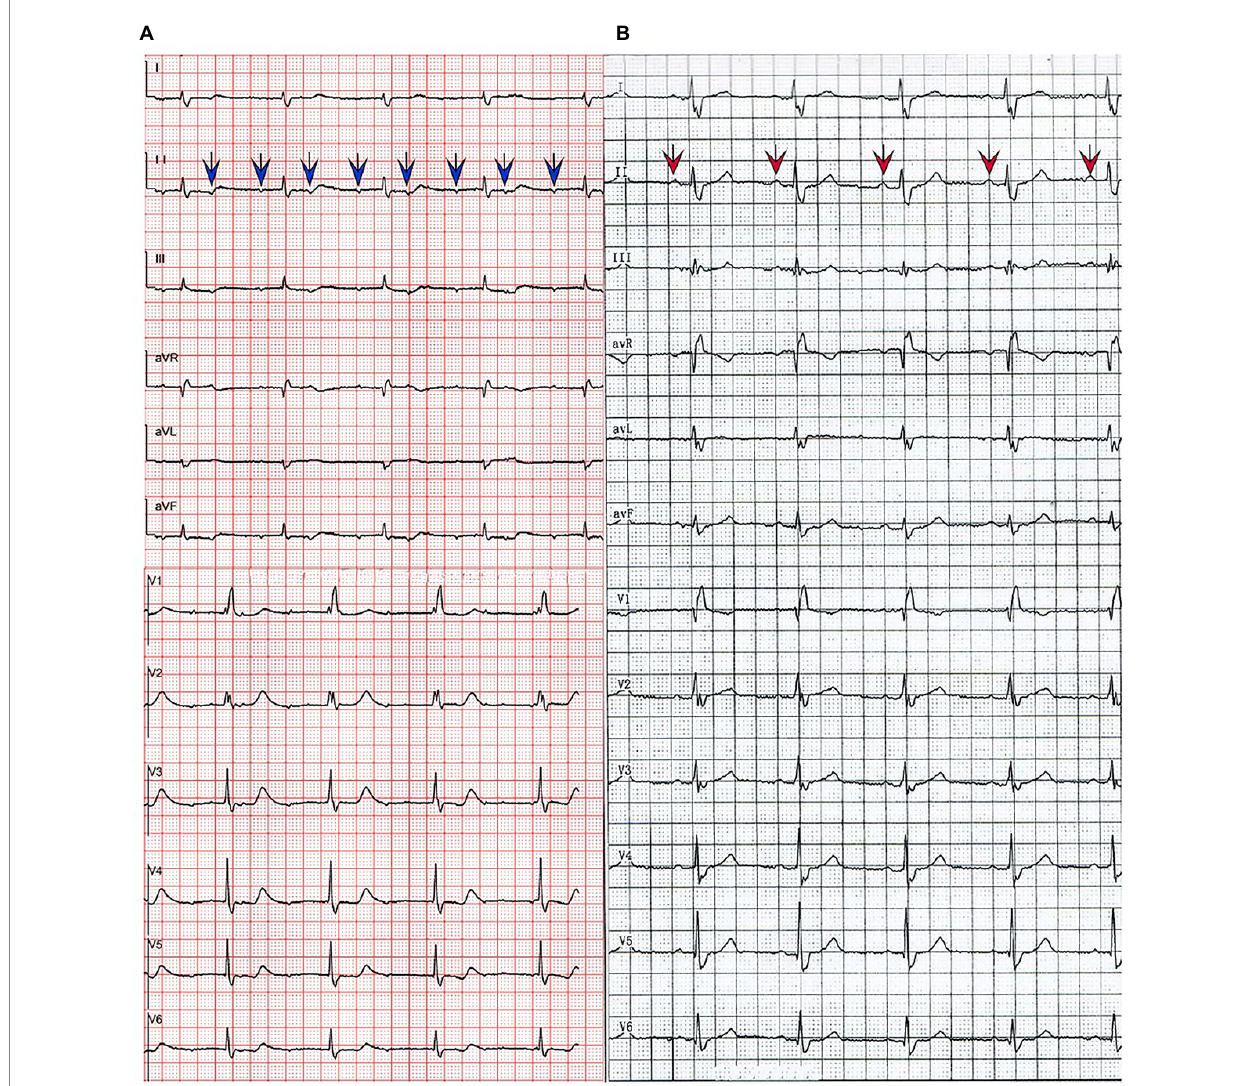
FIGURE 1 Electrocardiographic findings before (A) and after (B) treatment. The blue arrows indicate the patient’s blocked P-wave and the red arrows indicate the P-wave in sinus